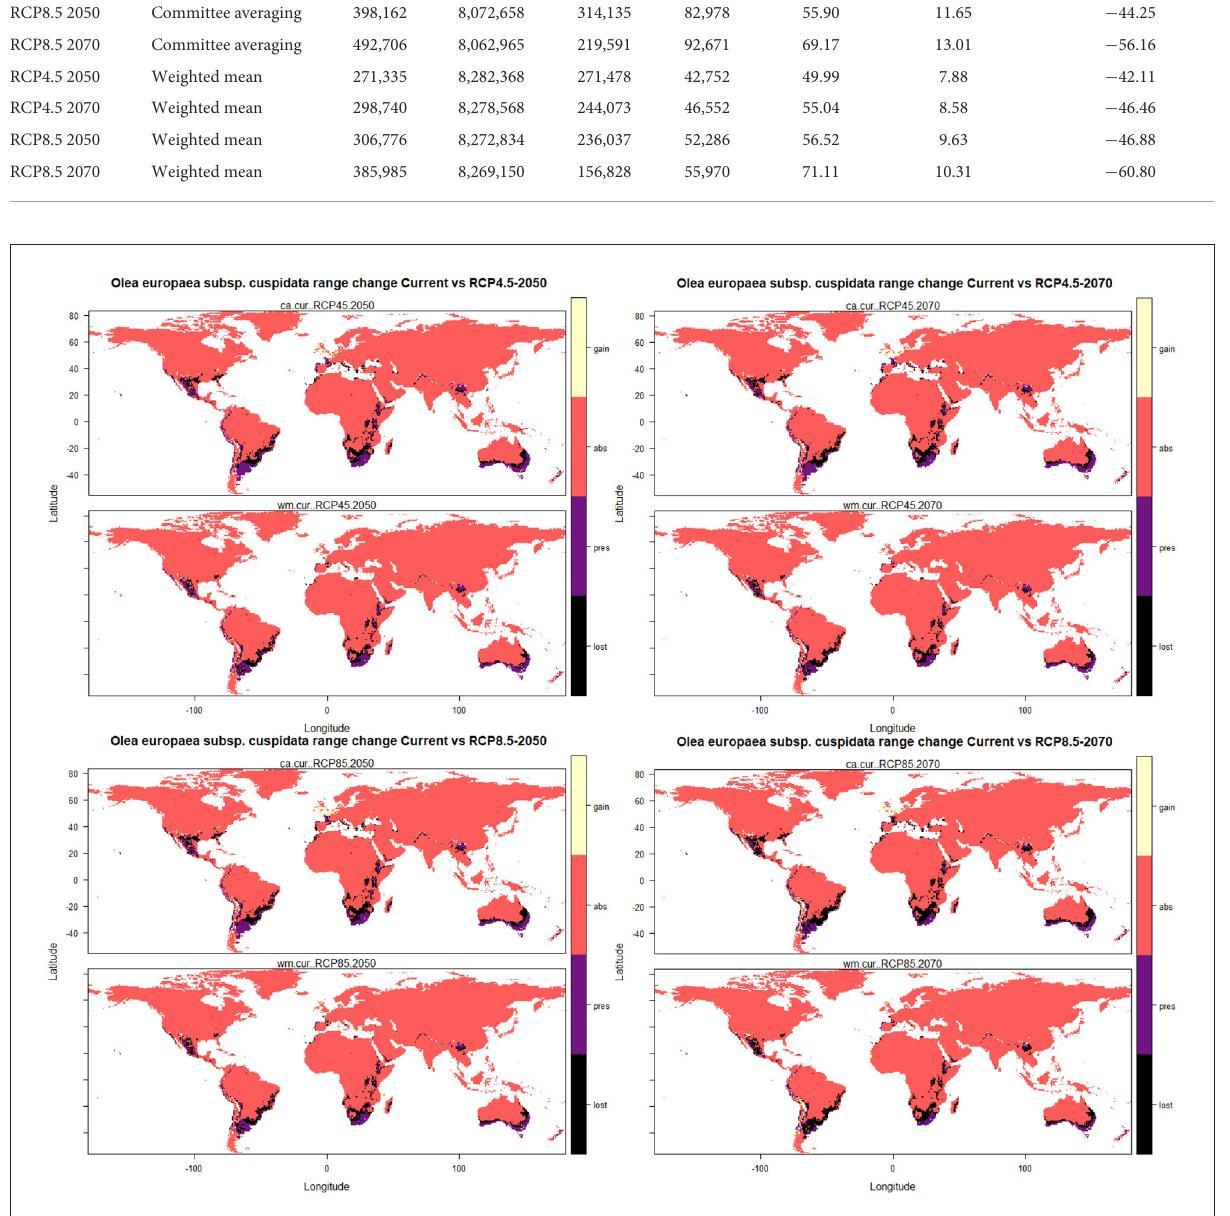
used to evaluate the accuracy of habitat suitability models, while TSS normalizes total accuracy (Allouche et al., 2006; Becerra-López et al., 2017). The threshold-independent AUC and threshold-dependent TSS performance scores for